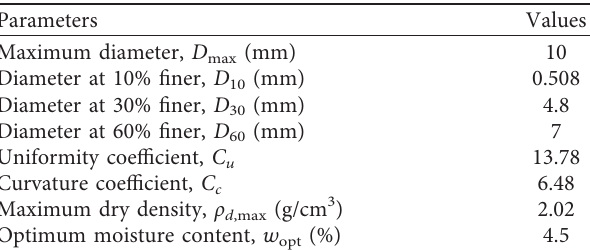
Figure 1: Grain size distribution of the coarse-grained material. Table 1: Basic physical characteristics of the frozen coarse-grained